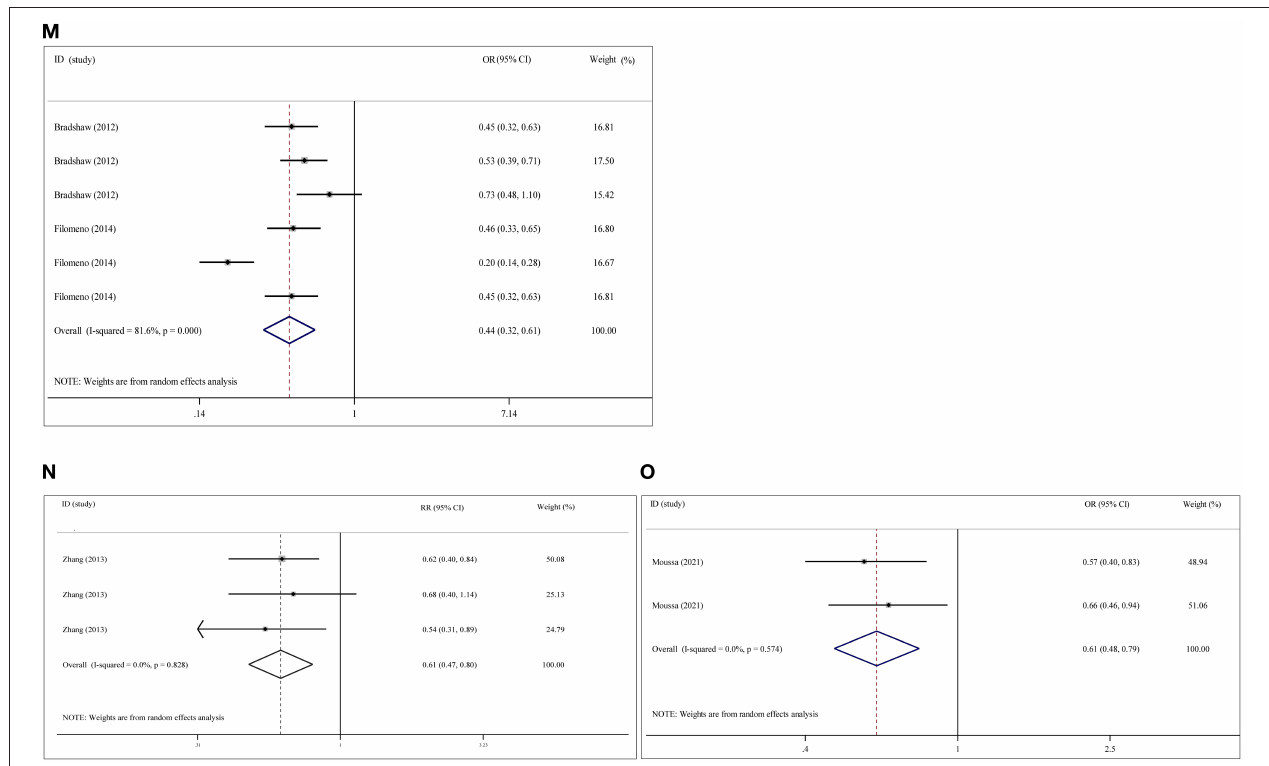
FIGURE 2 | Overall analysis of plant-based diets and cancer risk in cohort studies and case-control studies with risk ratio (RR), odds ratio (OR) and 95% confidence interval (CI). (A) Pancreas cancer with cohort study in overall analysis (adjusted). (B) Pancreas cancer with case- control study in overall analysis (adjusted). (C) Colorectal cancer with cohort study in overall analysis (adjusted). (D) Colorectal cancer with case-control study in overall analysis (adjusted). (E) Colon cancer with cohort study in overall analysis (adjusted). (F) Colon cancer with case- control study in overall analysis (adjusted). (G) Rectal cancer with cohort study in overall analysis (adjusted). (H) Rectal cancer with case-control study in overall analysis (adjusted). (I) Gastric cancer with cohort study in overall analysis (adjusted). (J) Gastric cancer with case-control study in overall analysis (adjusted). (K) esophagus cancer with cohort study in overall analysis (adjusted). (L) esophagus cancer with case-